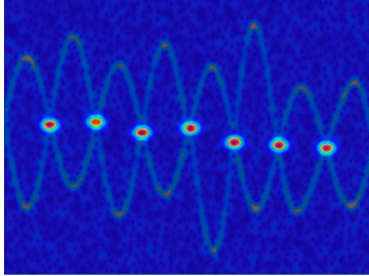
Figure 11. Heatmap of cross points.